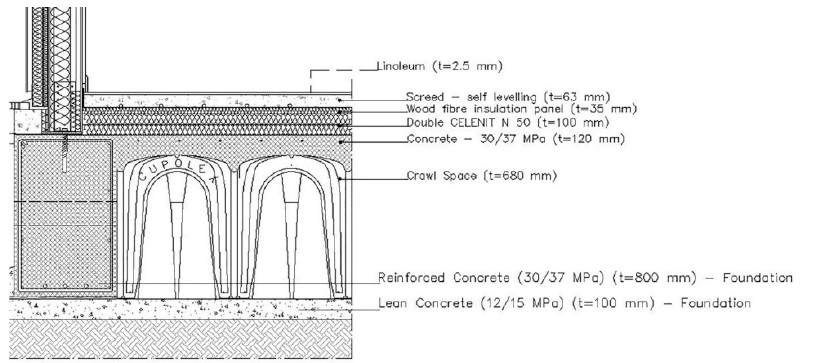
Figure 2. Foundation and ground floor sections.